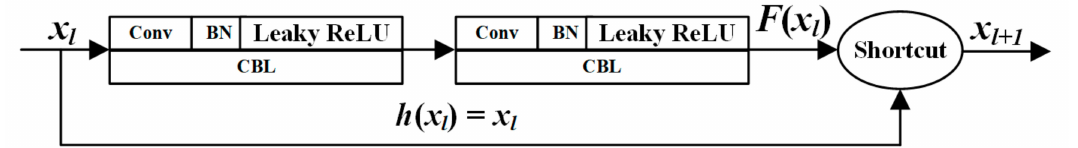
Figure 5. Building blocks of residual learning